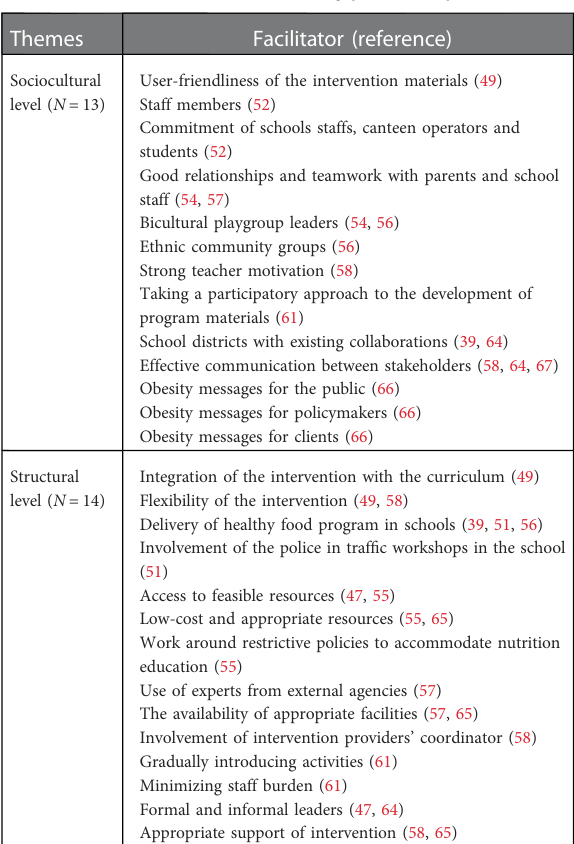
TABLE 4 Facilitators to childhood obesity prevention